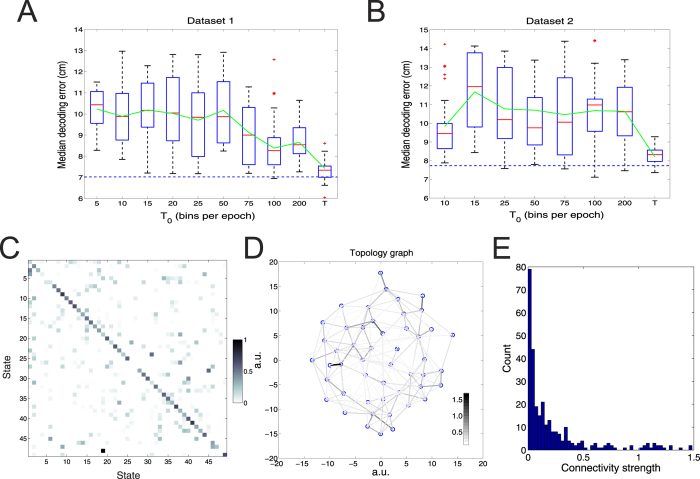
Illustration and decoding performance of population decoding methods.(A,B) Box plots of median decoding error from DecodewoRF with varying values of T0 (bins per epoch), for Datasets 1 and 2, respectively. The green curves are the averaged median decoding error. The median decoding error of DecodewRF was independent of T0 (horizontal dashed line; 7.02 for Dataset 1, 7.73 for Dataset 2). Representative examples of inferred state-transition matrix (C) from DecodewoRF and the derived topology graph (D) from Dataset 2 (dark color represents high connectivity strength). The percentage of nonzero entries in (C) is 14.8%. (E) Histogram of nonzero connectivity strengths (Pij + Pji, i ≠ j) for panel (C) (mean: 0.23; SD: 0.32).